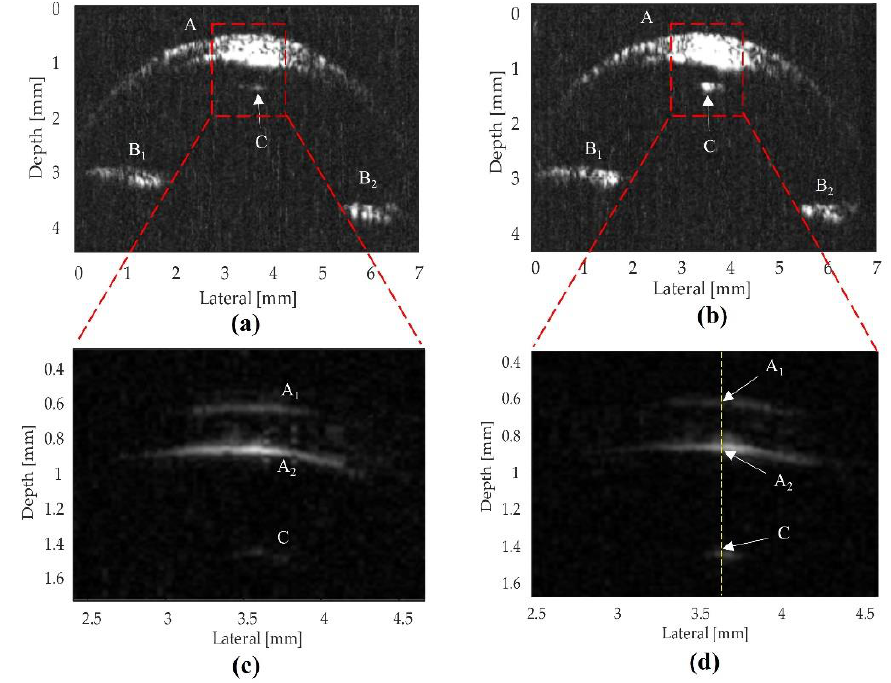
Figure 8. Before performing the mass–spring matching layer technique, an ultrasound biomicroscopy image (UBM) of the fish eye obtained with ( a ) the 103 MHz PMN-0.3PT transducer and ( b ) the 105 MHz LiNbO 3 transducer. ( c , d ) Enlarged view of the center of the cornea using the filter to remove the lower-frequency signal. The cornea (A), upper cornea surface (A 1 ), lower cornea surface (A 2 ), left iris (B 1 ), right iris (B 2 ), and lens (C) are visible in both images.